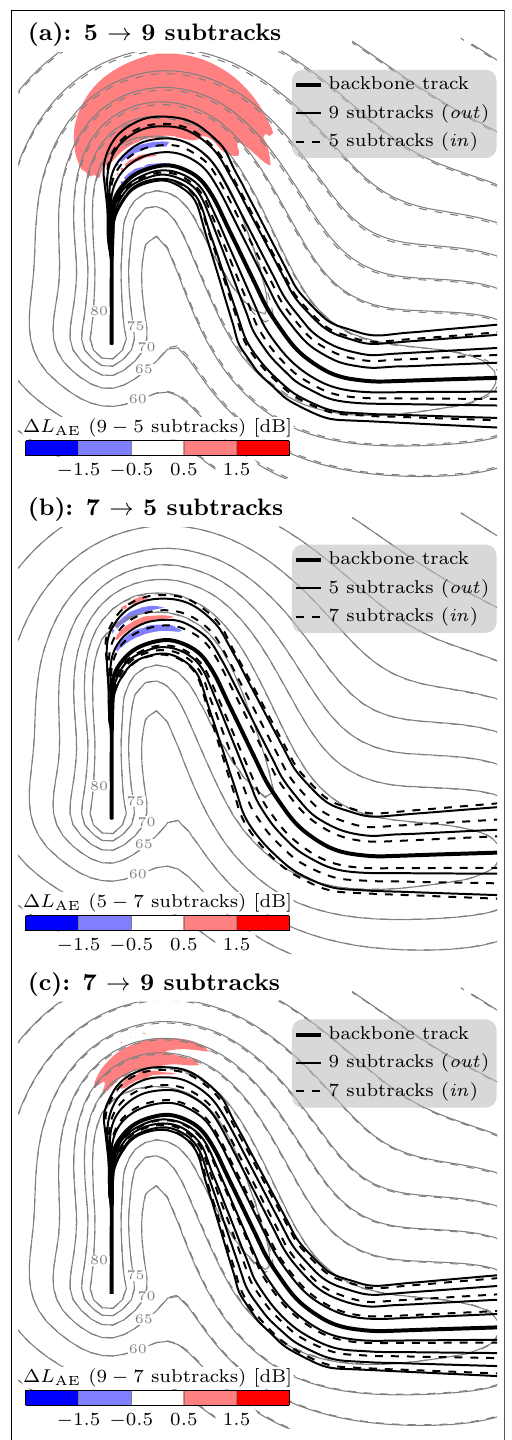
Figure 2: Differences in the resulting L AE on the receiver grid be- tween the calculation using (a) 9 and 5 , (b) 5 and 7 , and (c) 9 and 7 subtracks, with normal distributions in all cases, assuming the movement percentages from Table 1, for an A320